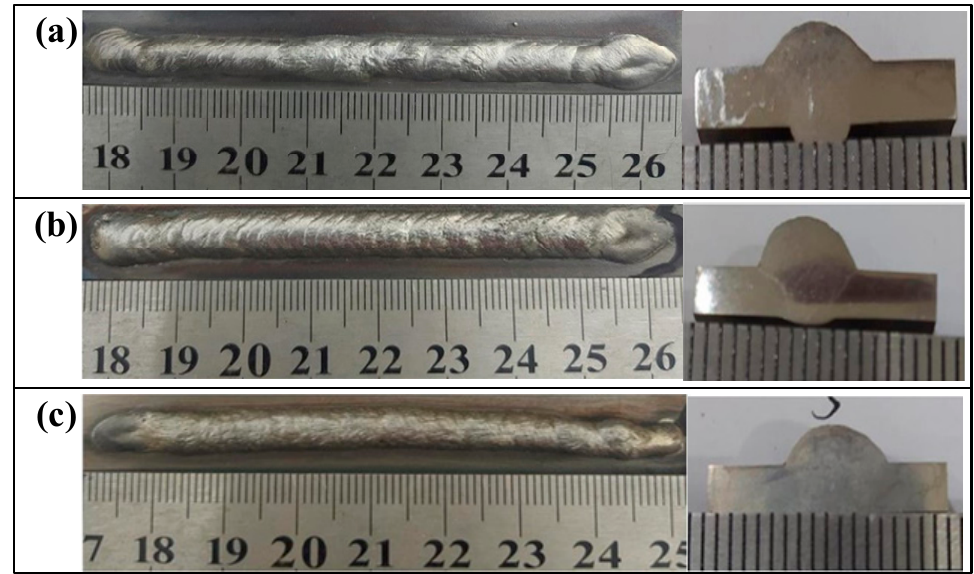
Figure 12. Macroscopic morphology of deposition layer ( a ) free transfer + free transfer ( b ) bridge transfer + free transfer ( c ) bridge transfer + bridge transfer.